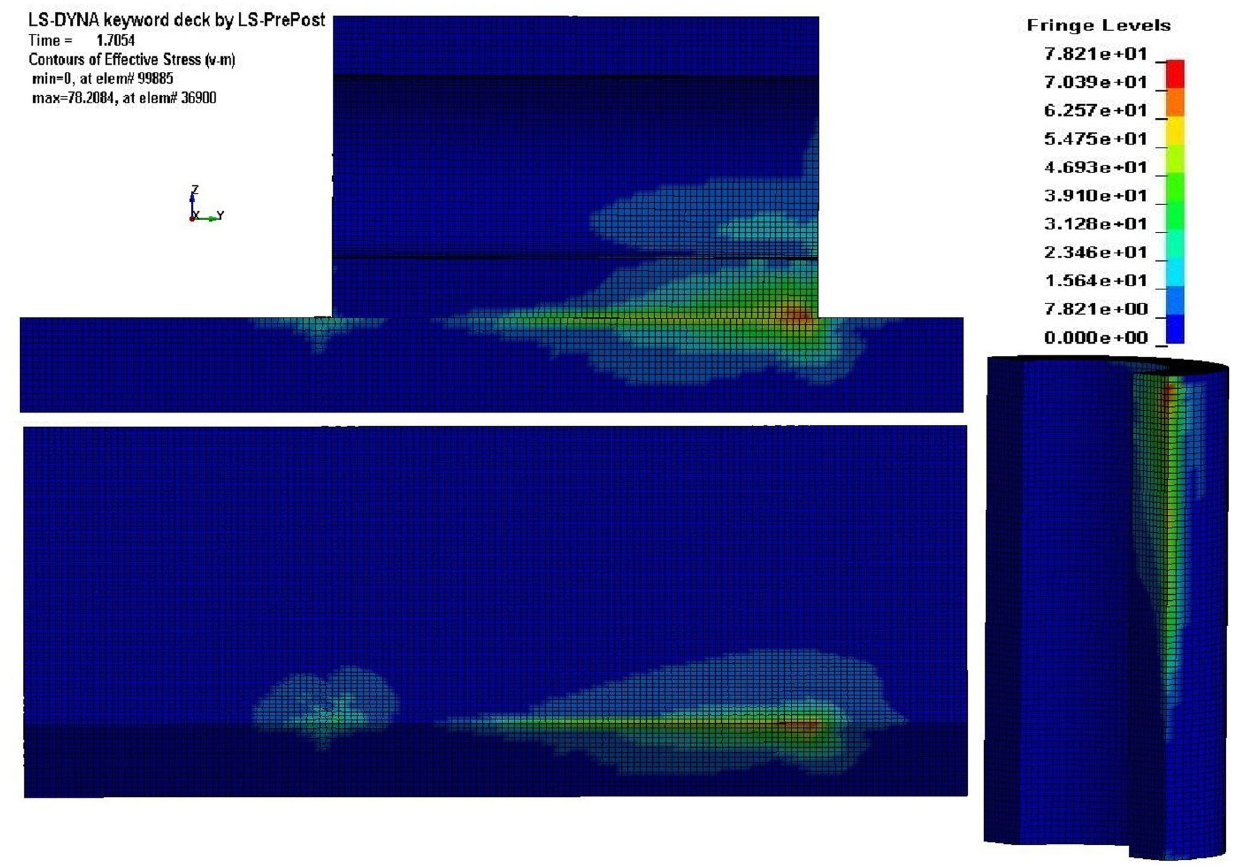
Fig. 19 Contours of von-Mises stress (MPa) at t = 1.7054 s.